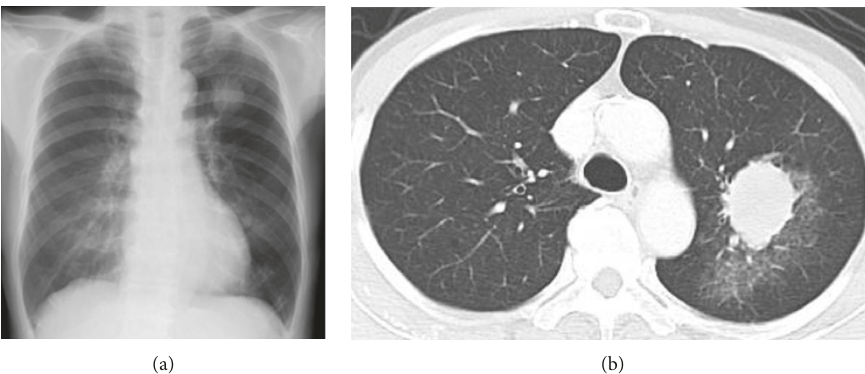
Figure 1: Chest X-ray showing an apparent nodule in the left upper lung field (a). Contrast-enhanced computed tomography of the chest, showing a large nodule with surrounding ground-glass opacity in the left upper lobe of the lung (b).